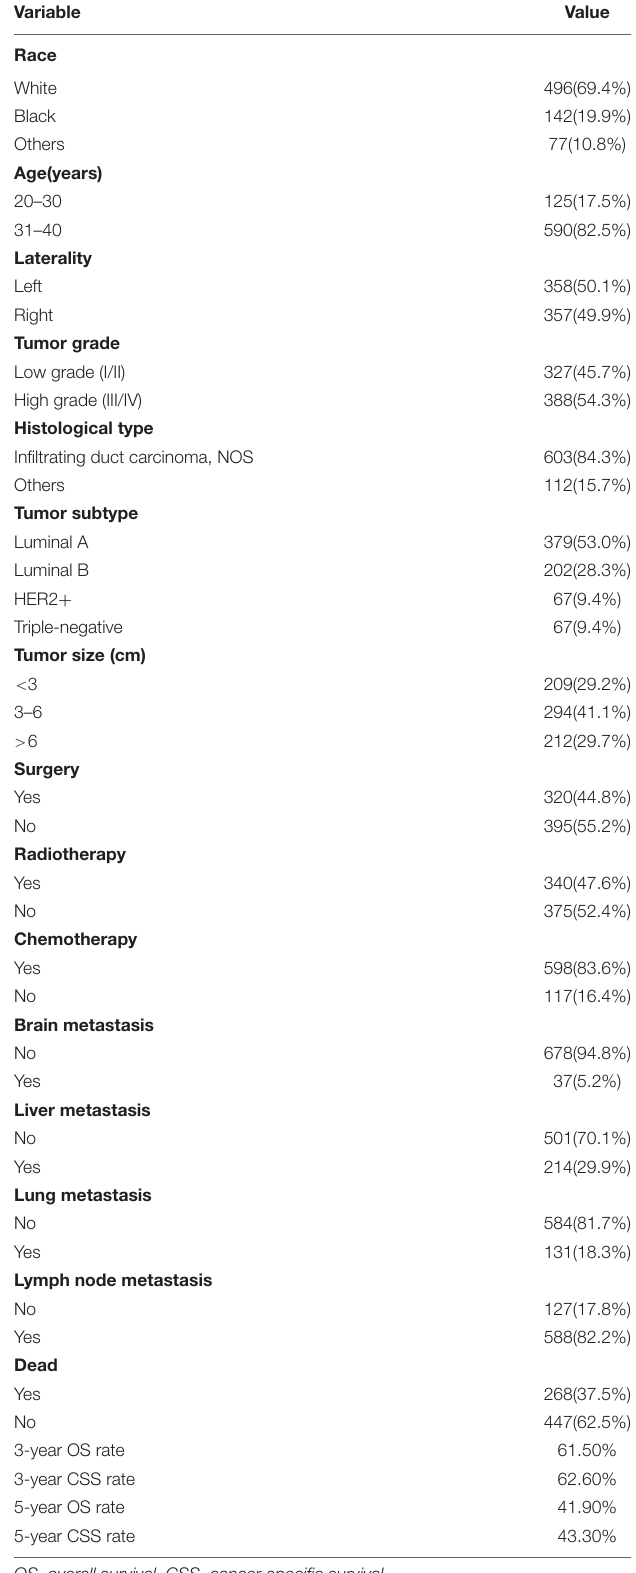
TABLE 1 | Demographics of 715 young breast cancer bone